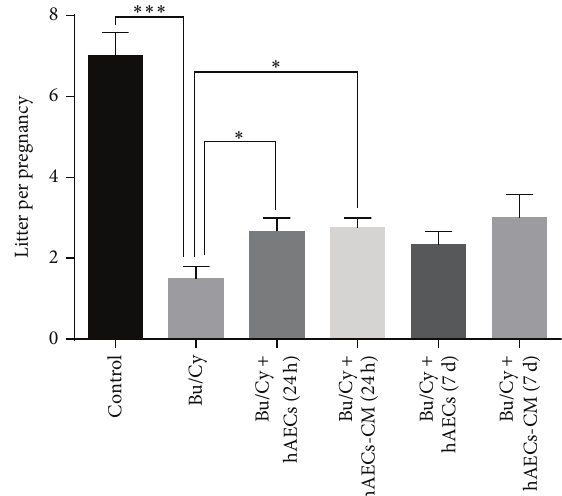
Figure 4: Intraperitoneal injection of hAECs and hAECs-CM could partly restore fertility in mice treated with chemotherapy. The litter sizeperpregnancywasrecorded.Datarepresentmeans ± SEM, ∗ 𝑃 < 0.05 , ∗∗∗ 𝑃 < 0.001